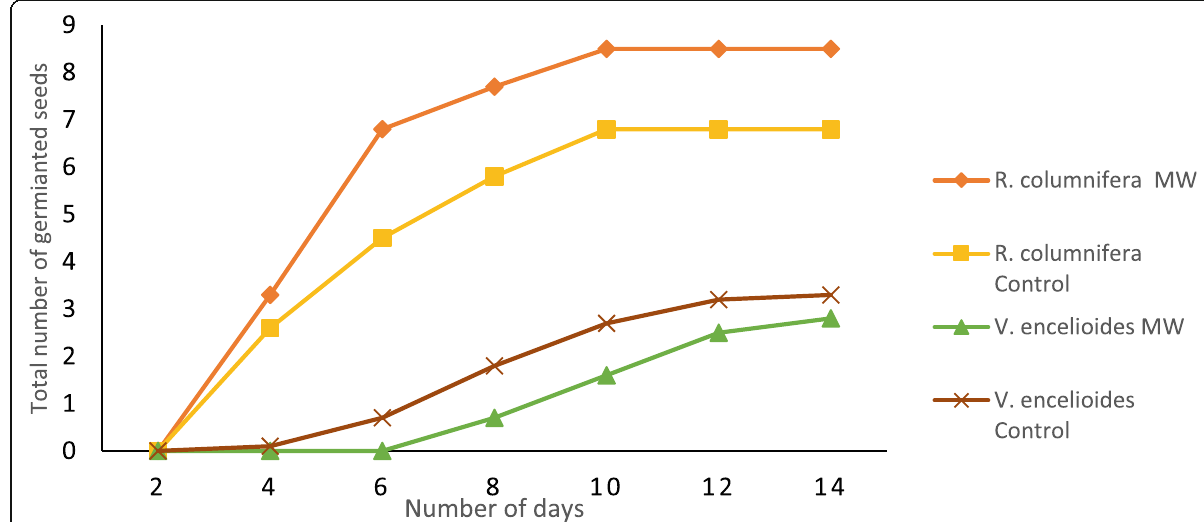
Fig. 2 The total germination rate for V. encelioides and R. columnifera treated with a microbial wash (MW) and without any treatment (control) over the 14-day